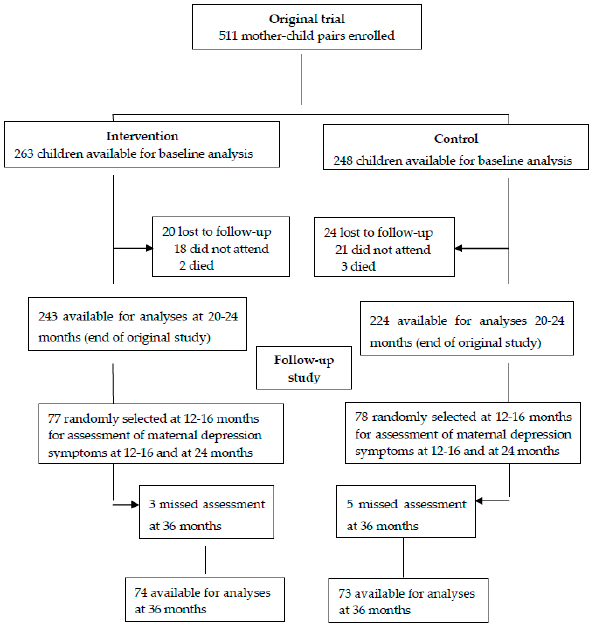
Figure 1. Flow chart of the inclusion process.